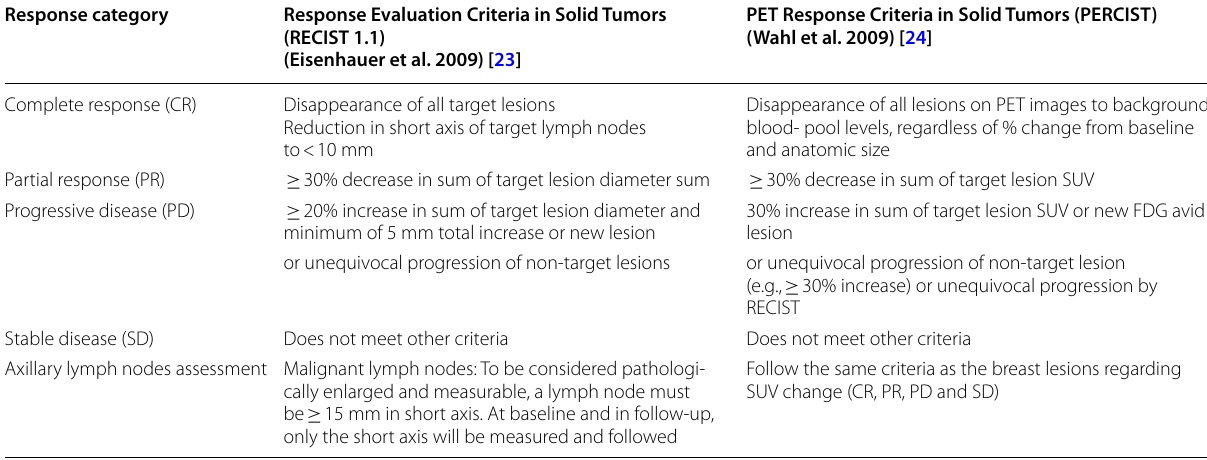
Table 1 Criteria for evaluation of response of breast lesions and axillary lymph nodes by DCE‑MRI versus PET/CT Response